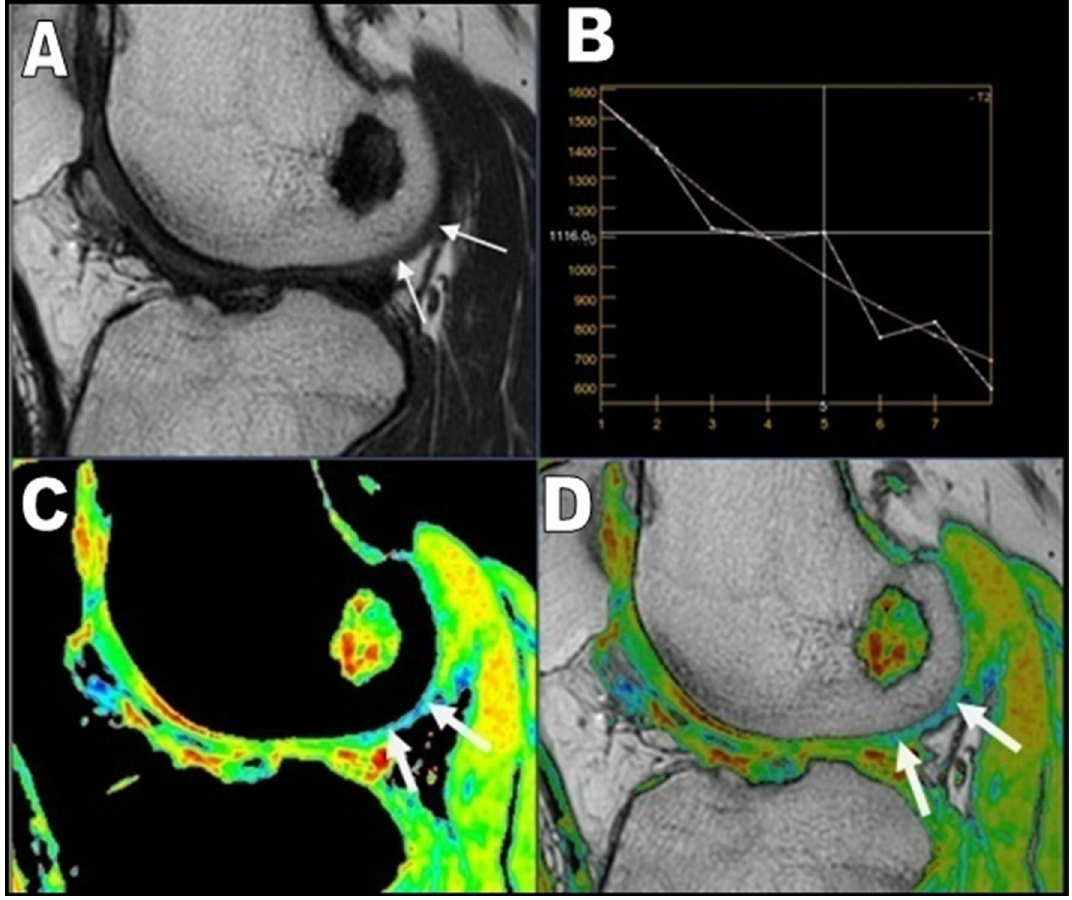
Fig. 10 A 27-year-old male patient underwent ACL reconstruction 3 years ago, the patient complained of knee pain and swelling. In assessment of the MRI knee, the conventional images shows mild knee joint effusion with intact ACL graft. Sagittal T2 image ( A ) at lateral femoral condyle level shows mild thinning of the articular cartilage upon the lateral femoral condyle posterior and middle segments (White arrows). On the post processing colour coded T2 mapping image: ( C , D ) The colour image along the articular cartilage of the lateral femoral condyle posterior and middle segments shows intrasubstance linear areas of blue colour with increased T2 value (as demonstrated within the curve image ( B )) that corresponds to articular cartilage degeneration. According to the international cartilage Repair Society (ICRS) grading system, this corresponds to grade II